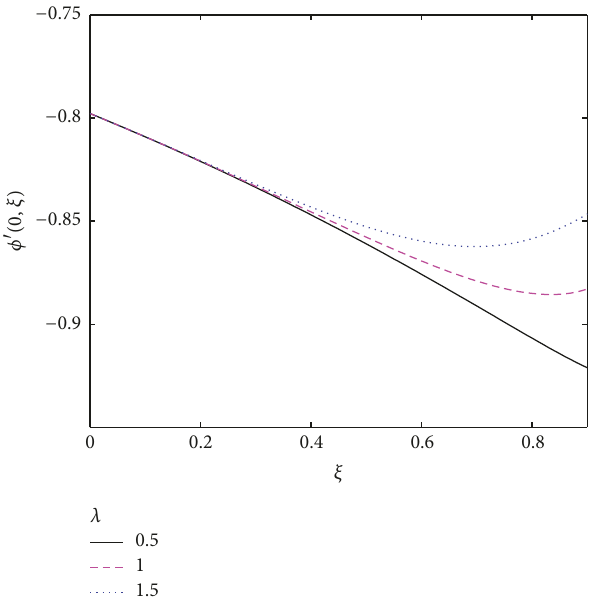
Figure 26: Effect of 𝜎 on 𝜙 󸀠 (0, 𝜉) ( 𝜆 = 1, 𝛾 = 0.5, Pr = 3, Sc = 2, ℏ = −0.5 ).